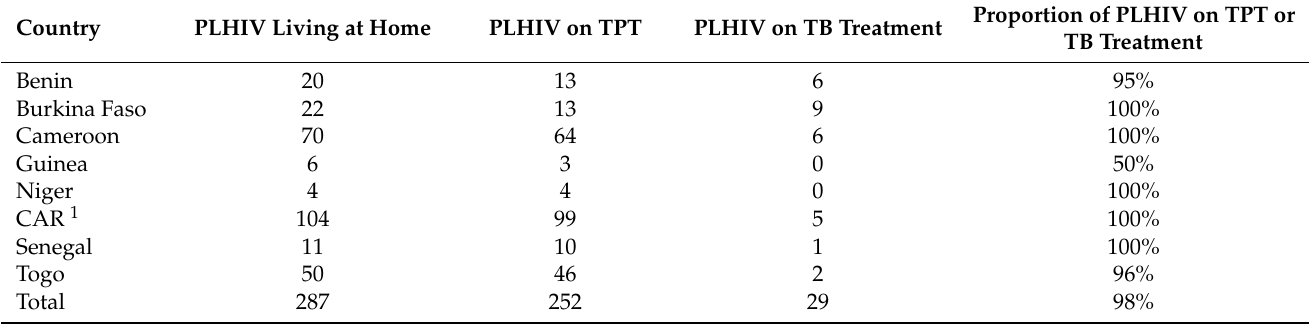
Table 3. Proportion of PLHIV living at home and on preventive treatment or TB treatment.